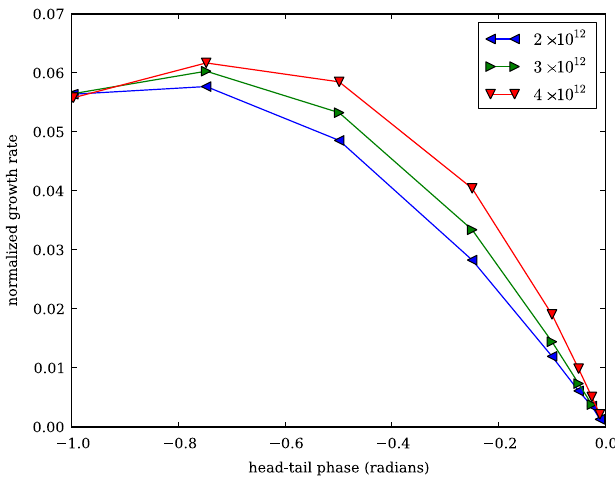
FIG. 7. (Color) Schematic of the position of proton and anti- proton bunches in the Tevatron with 36 proton and 36 antiproton bunches. The diagram shows the positions at a time when the lead bunches of the trains are at the head-on collision location. Head-on collisions occur at location B0 and D0. The green shading indicates the part of the ring where beam-beam colli- sions may occur in the simulations with six-on-six